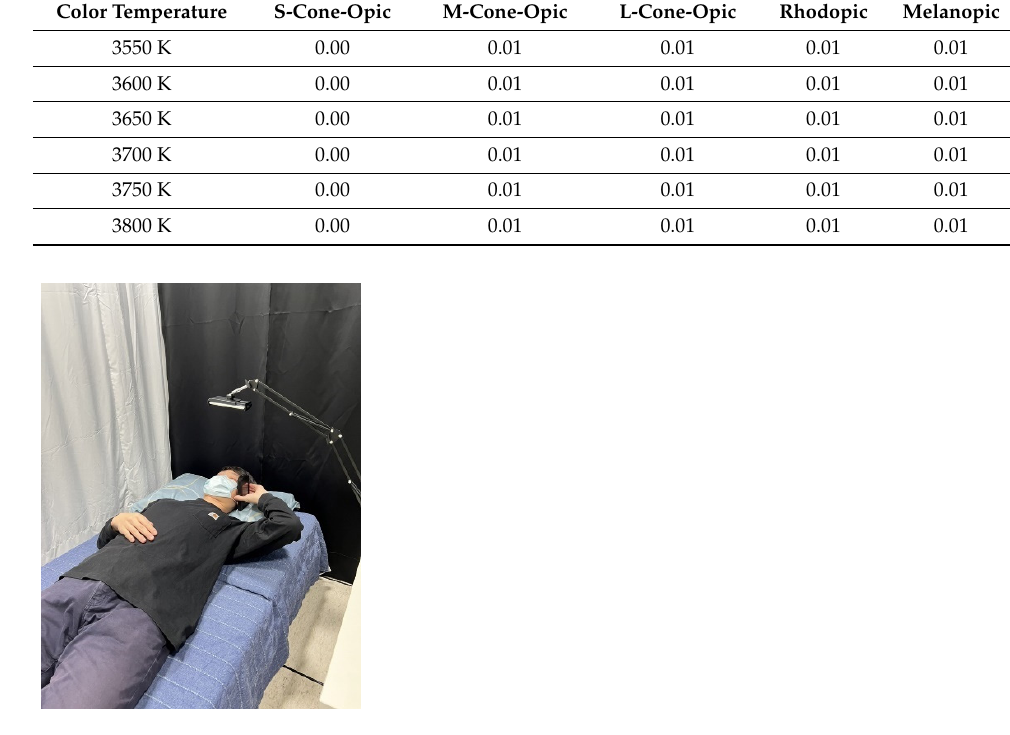
Figure 15. Schematic diagram of the measurement before the subject’s sleep experiment. Table 2. Subjective